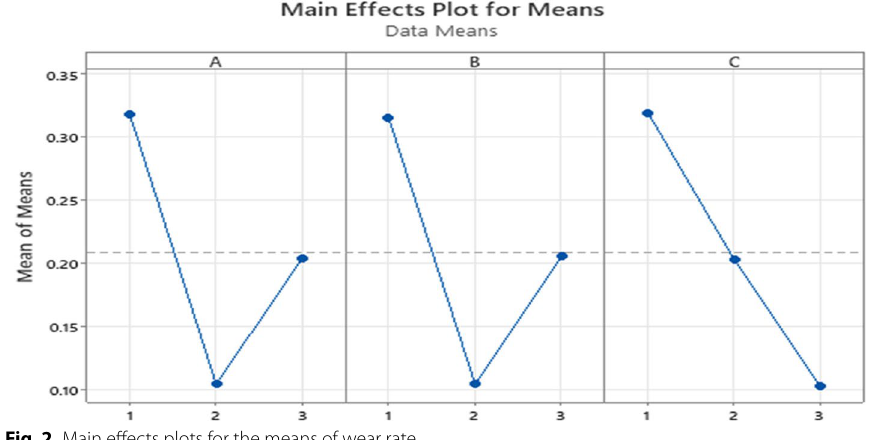
Fig. 2 Main effects plots for the means of wear rate